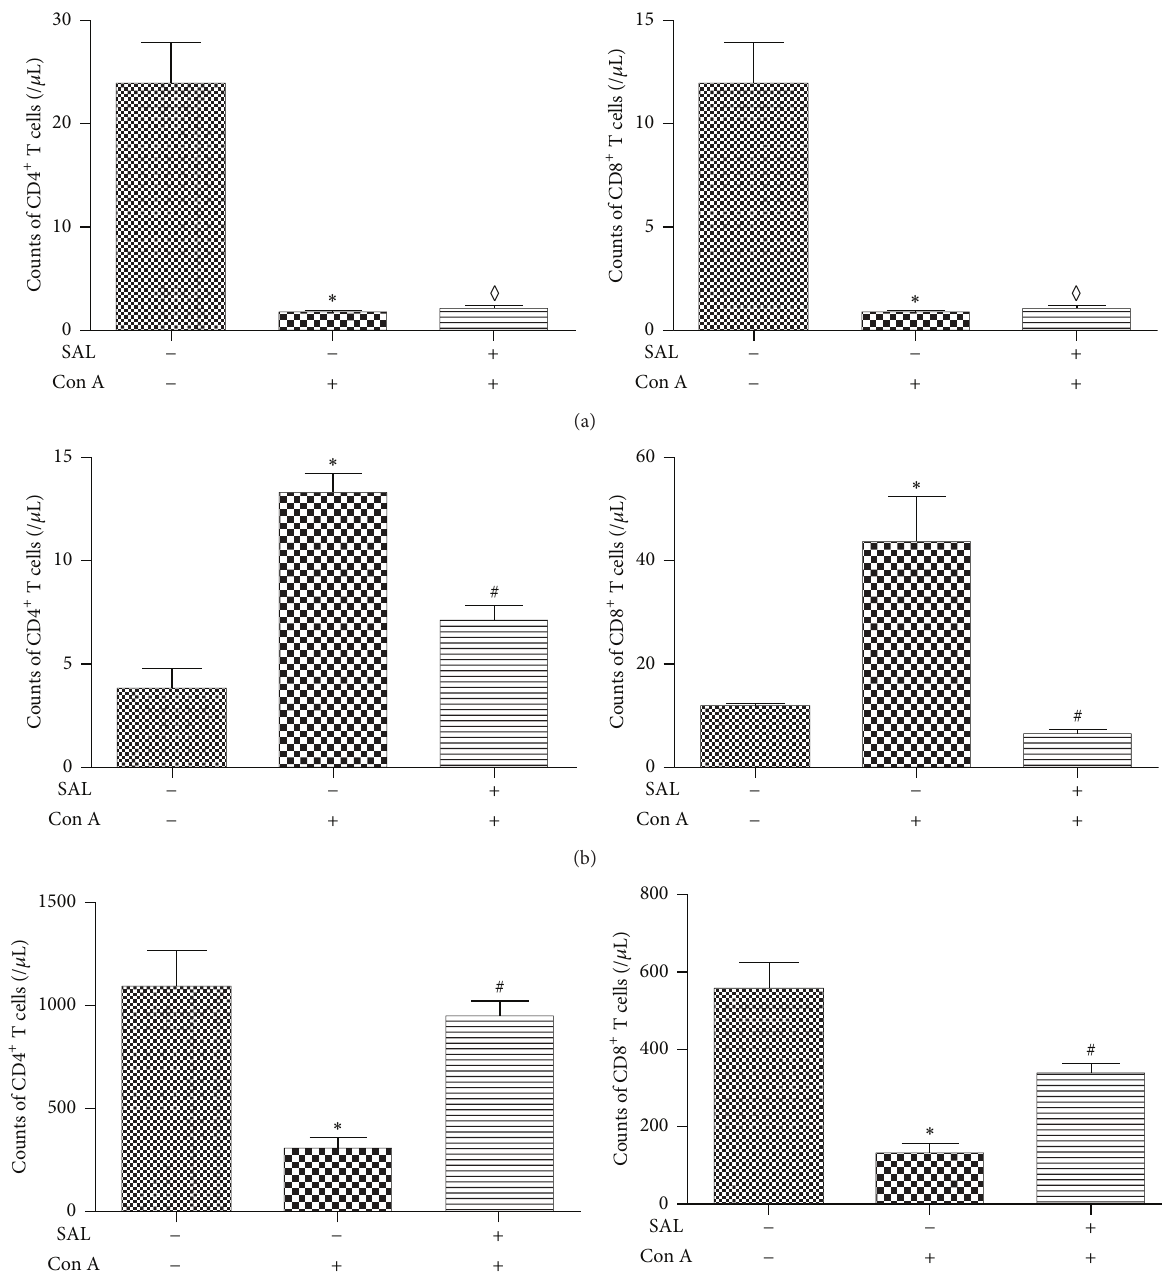
Figure 6: The effect of salidroside on T lymphocytes infiltrated in the blood, liver, and spleen. (a) The number of CD4 + and CD8 + T lymphocytes in the blood did not show any difference between Con A group and salidroside group. (b) The number of CD4 + and CD8 + T lymphocytes in the liver increased significantly after Con A administration. Salidroside pretreatment reduced the liver-infiltrating CD4 + andCD8 + Tlymphocytes.(c)ThenumberofCD4 + andCD8 + TlymphocytesinthespleendecreaseddramaticallyafterConAadministration; salidroside pretreatment reversed the variation of CD4 + and CD8 + T lymphocytes recruited to the spleen. ∗ 𝑃 < 0.01 versus control group, # 𝑃 < 0.05 versus Con A group, ◊ 𝑃 > 0.05 versus Con A